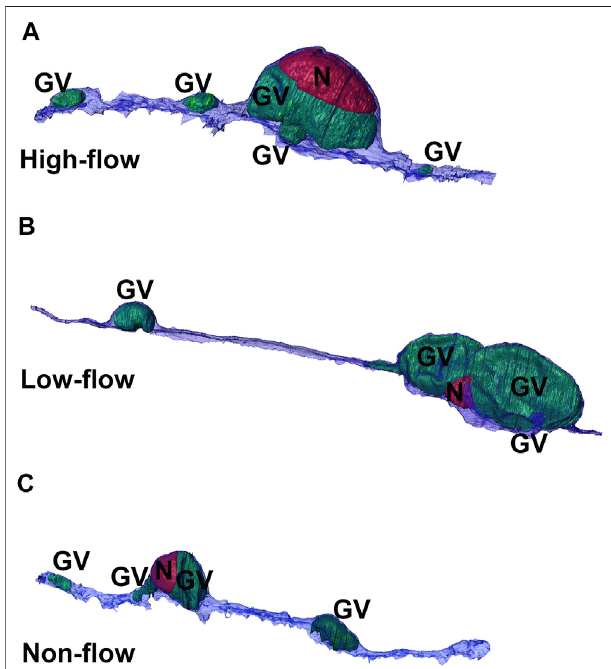
FIGURE 5 | 3D reconstructions of cells from three fl ow-type areas. Representative 3D reconstructions of Schlemm ’ s canal inner wall endothelial cells from high- (A) , low- (B) , and non- fl ow (C) areas. Cells typically had one or two large giant vacuoles (GVs, green ) near the nucleus (N, red ) with smaller GVs throughout the length of the